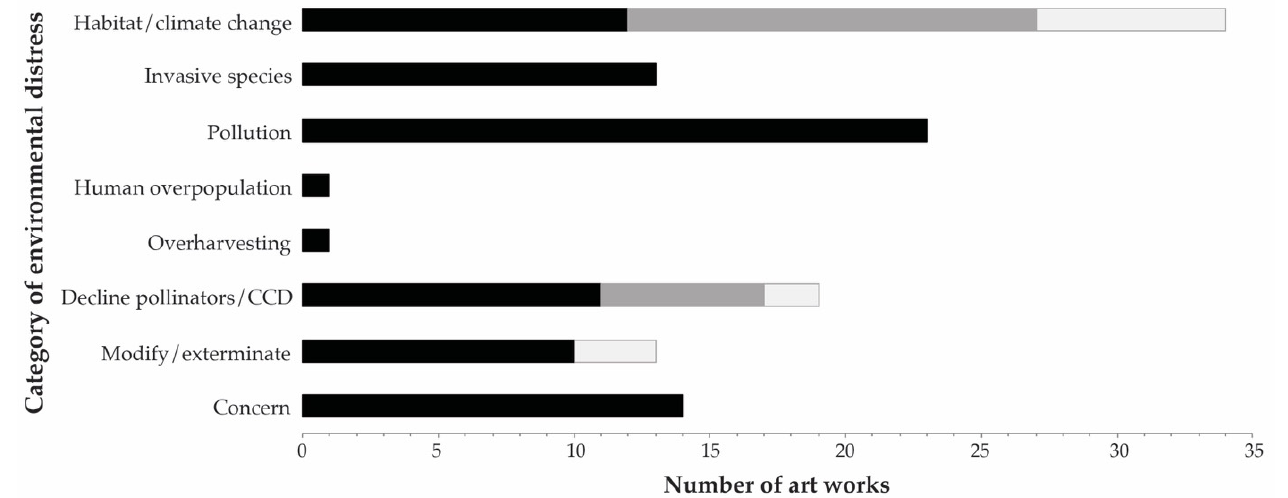
Figure 7. Number of artworks related to categories of human-induced environmental distress. Each artwork potentially relates to more than one category of environmental distress, but each category is calculated here no more than one time per artist ( n = 118 category associations across 73 artists). CCD = colony collapse disorder. Modify/exterminate refers to the intentional modification or extermination of insects. Concern indicates general concern for the environment or for insects, when a more specific categorical assignment could not be made. Black bars represent the first component for each category (e.g., habitat destruction), and light grey bars represent the second component (e.g., climate change). Dark grey bars signify a combination of the two (e.g., habitat destruction and climate change were both cited as relevant to the artwork). From top to bottom, the first five categories were largely adopted from what E.O. Wilson considered the top causes of species extinction, encapsulated in the acronym HIPPO [32].